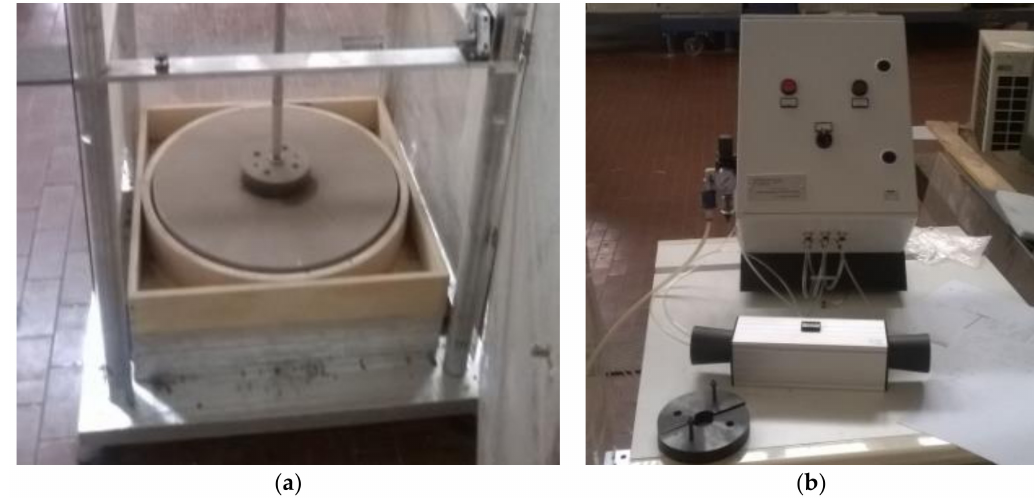
Figure 6. Plate on sample after a compaction test ( a ) and two-hand tripping control system ( b ).